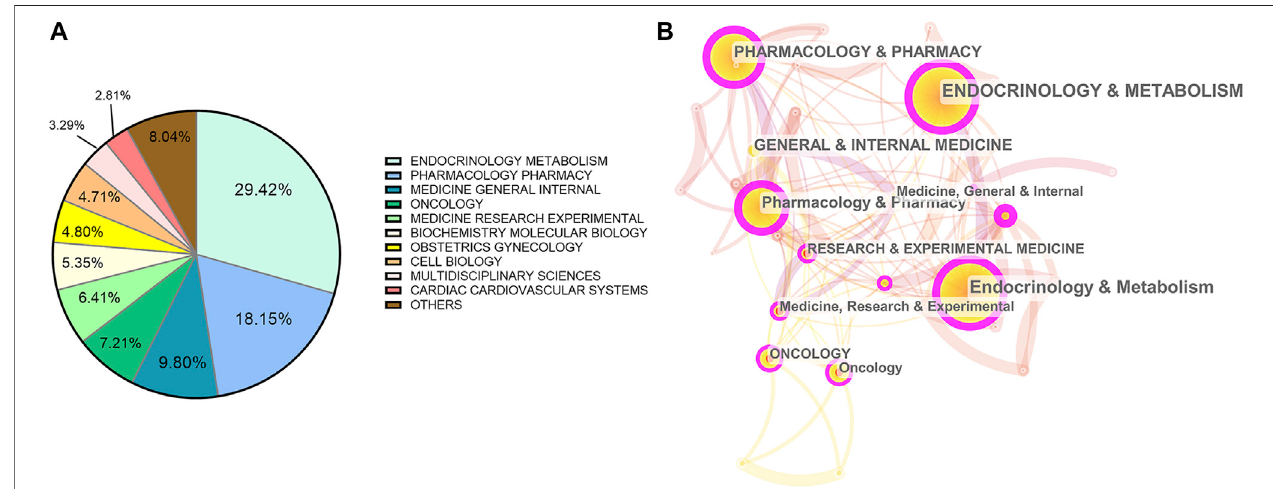
FIGURE 5 | Analysis of categories. (A) The top 10 most published subjects within metformin area. (B) A category visualization of metformin